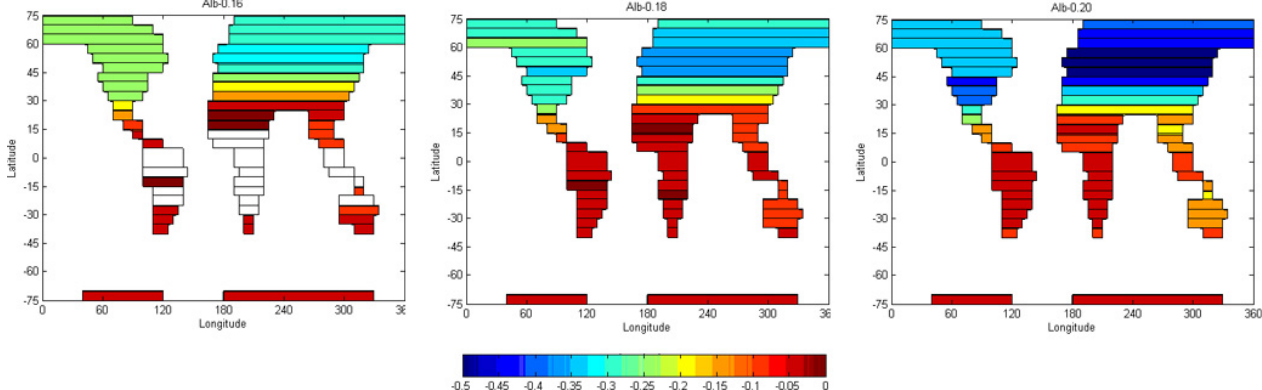
Fig. 3. Averaged changes in surface air temperature ( ◦ ) for different surface albedos. (a) Grassland albedo of 0.16; (b) grassland albedo of 0.18; (c) grassland albedo of 0.20. Only areas where changes are significant at a 95% confidence using the Student’s t test are